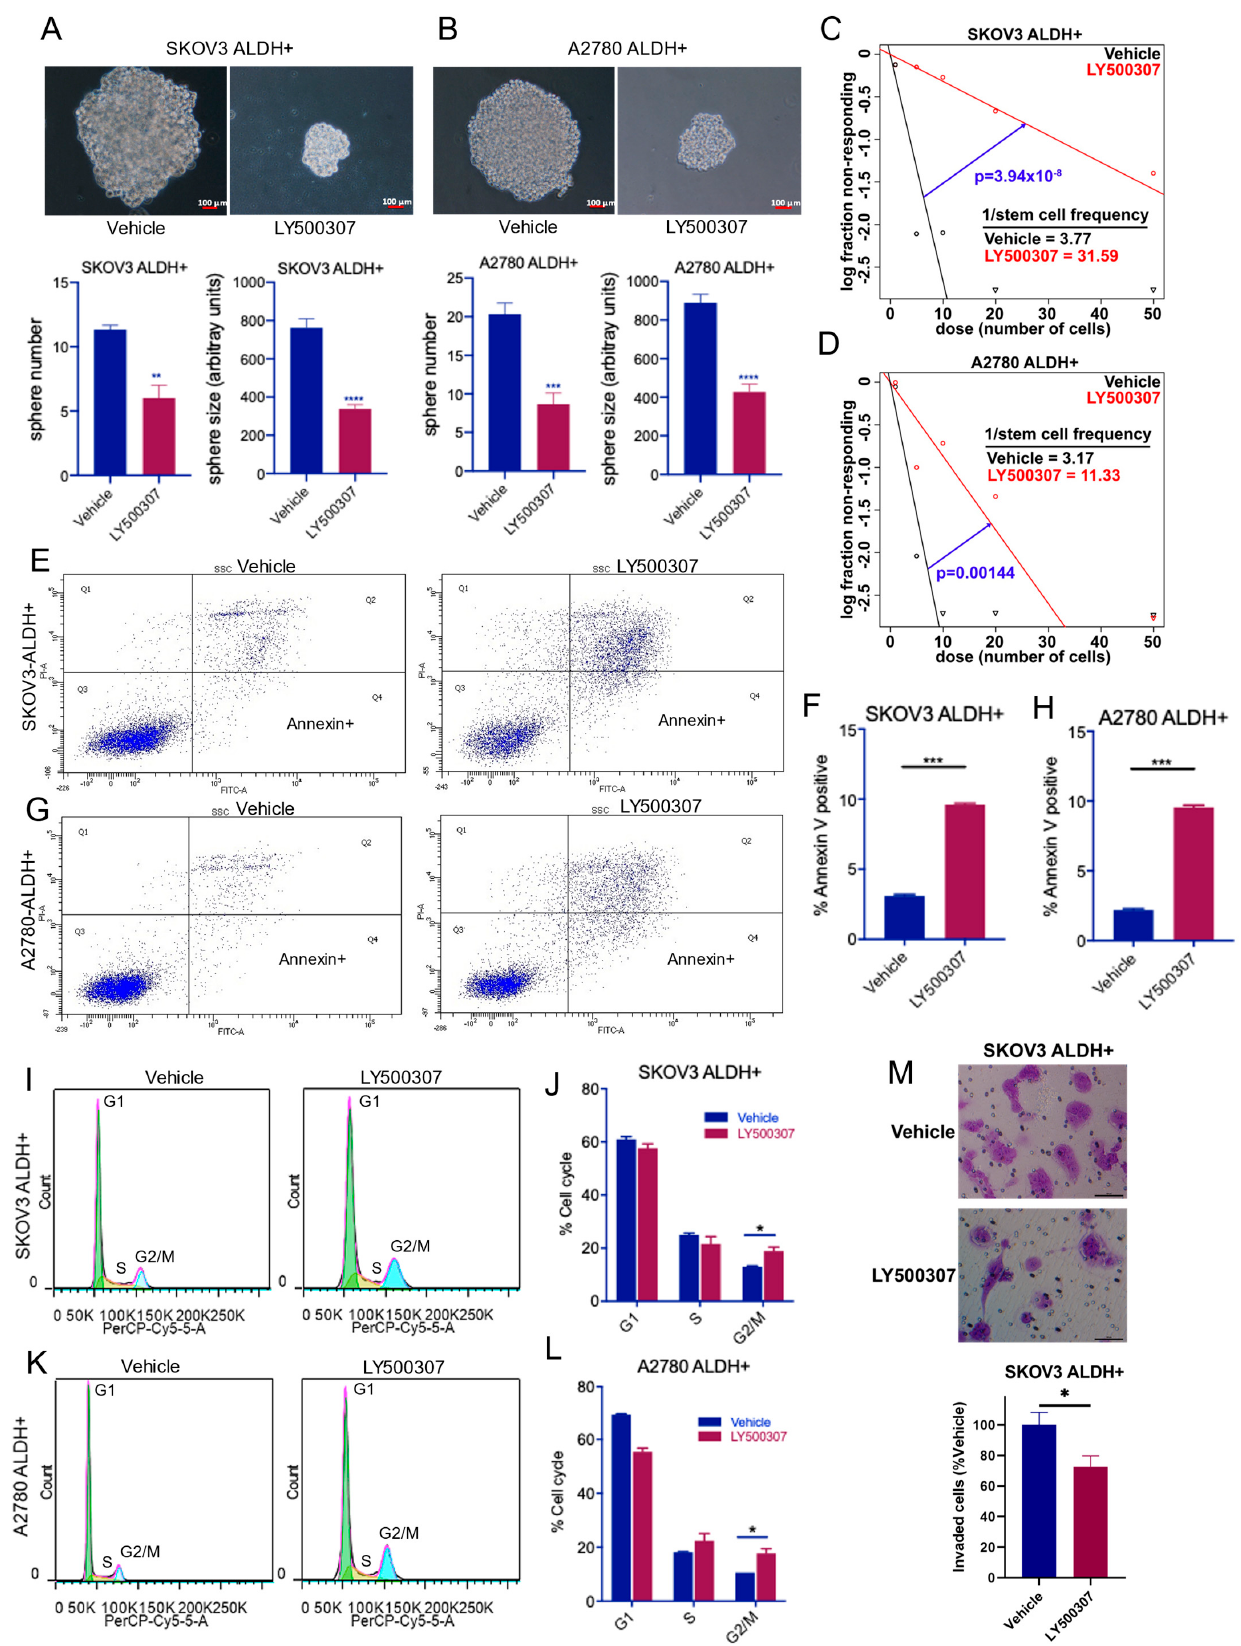
Figure 2. ER β agonist LY500307 reduced sphere formation and self-renewal, and promoted the apoptosis and cell cycle arrest of OCSCs. ( A , B ) SKOV3- and A2780- ALDH+ve cells were